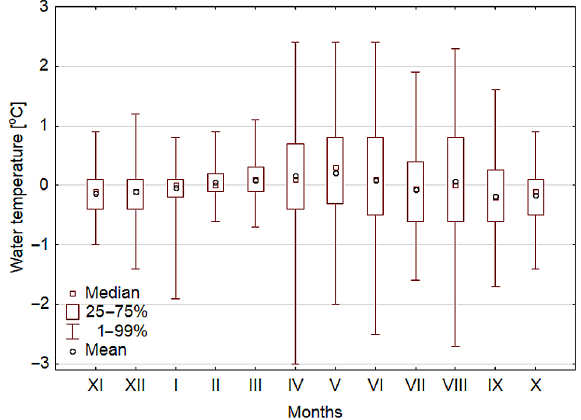
Fig. 6. Relationship between monthly average water temperature and monthly average air